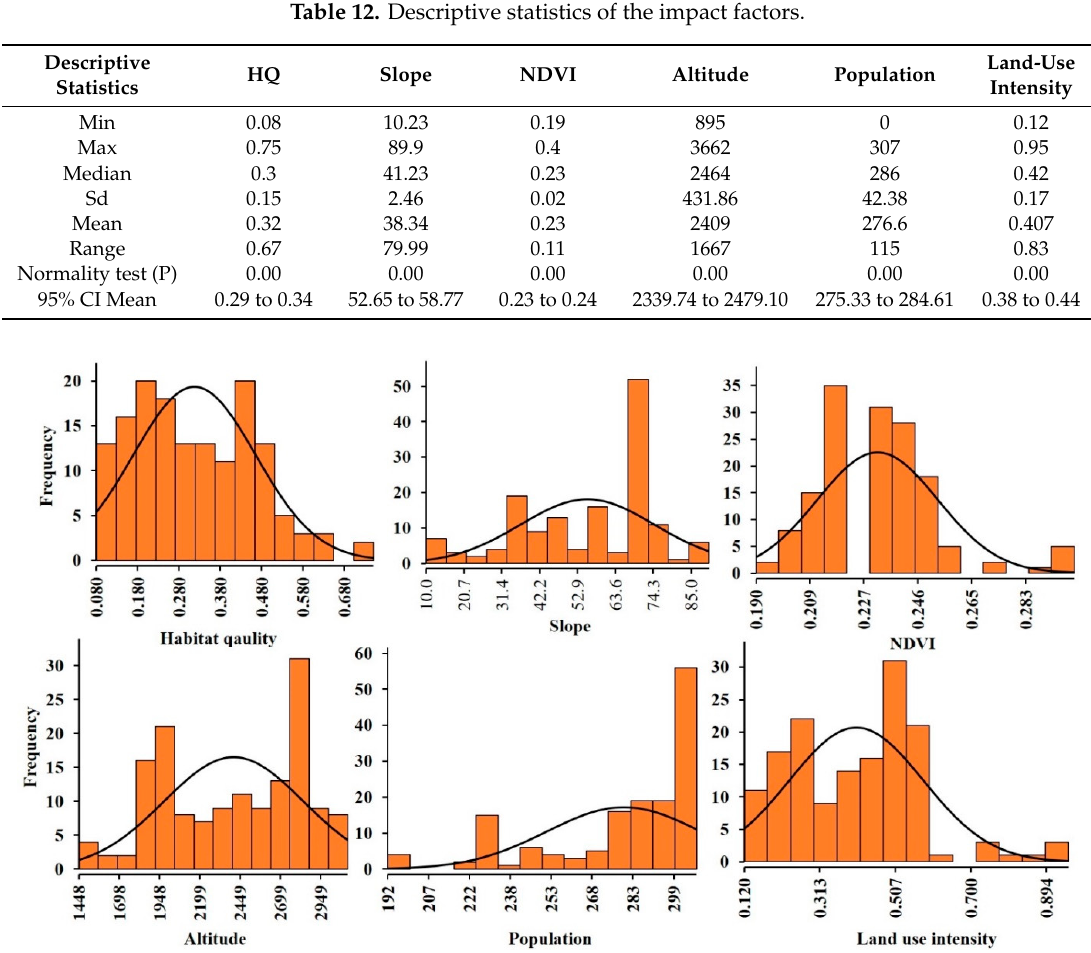
Figure 11. The distribution of habitat impact factors and normality test.